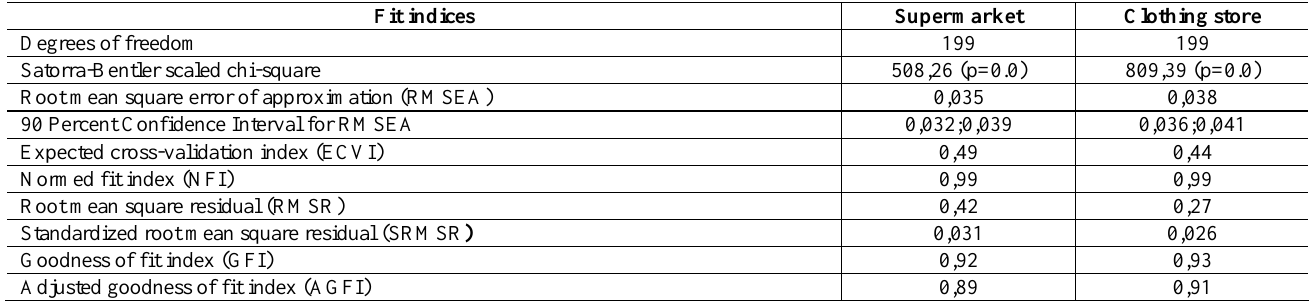
Table 2: Fit indices of the ise instrument for supermarkets and clothing stores Fit